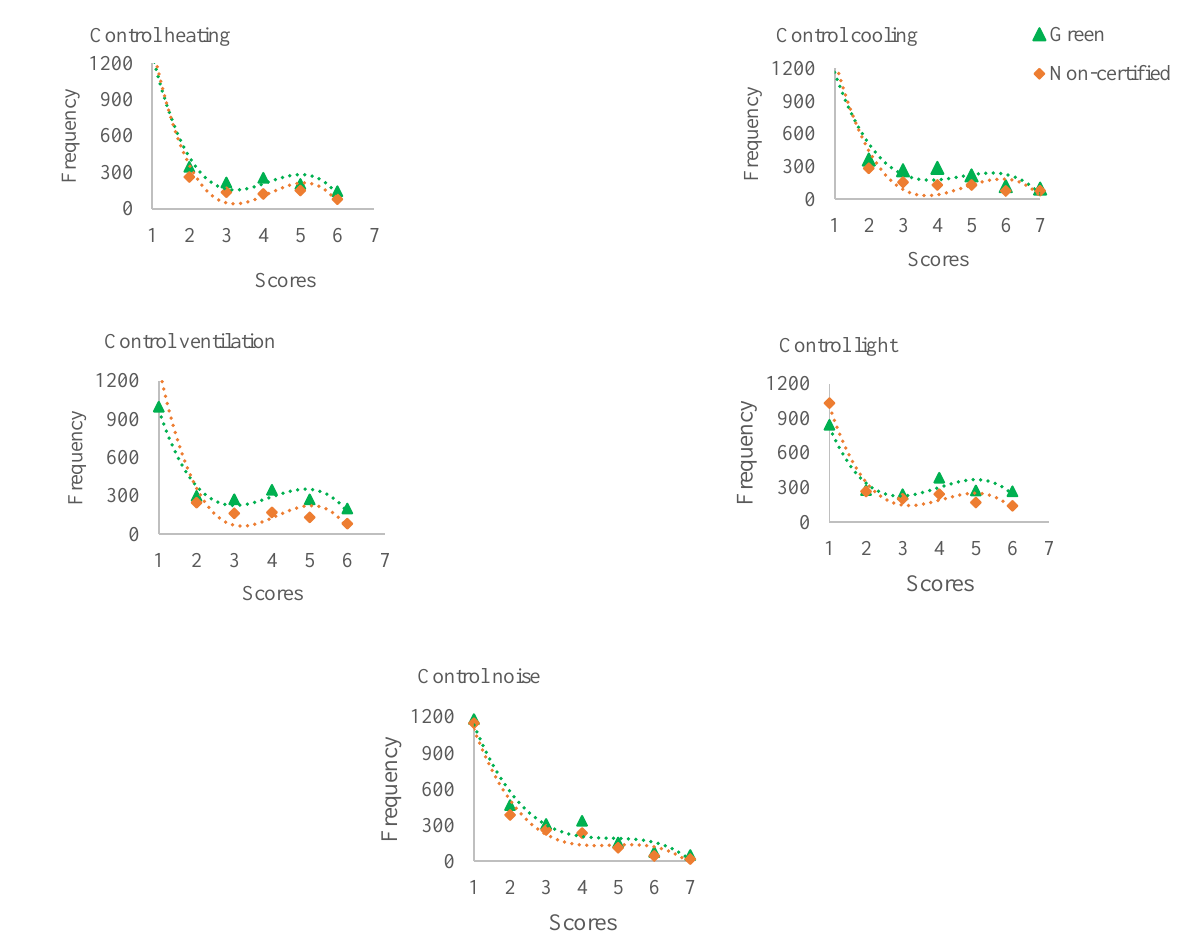
Figure 4. Distribution characteristics of median scores for perceived control parameters.